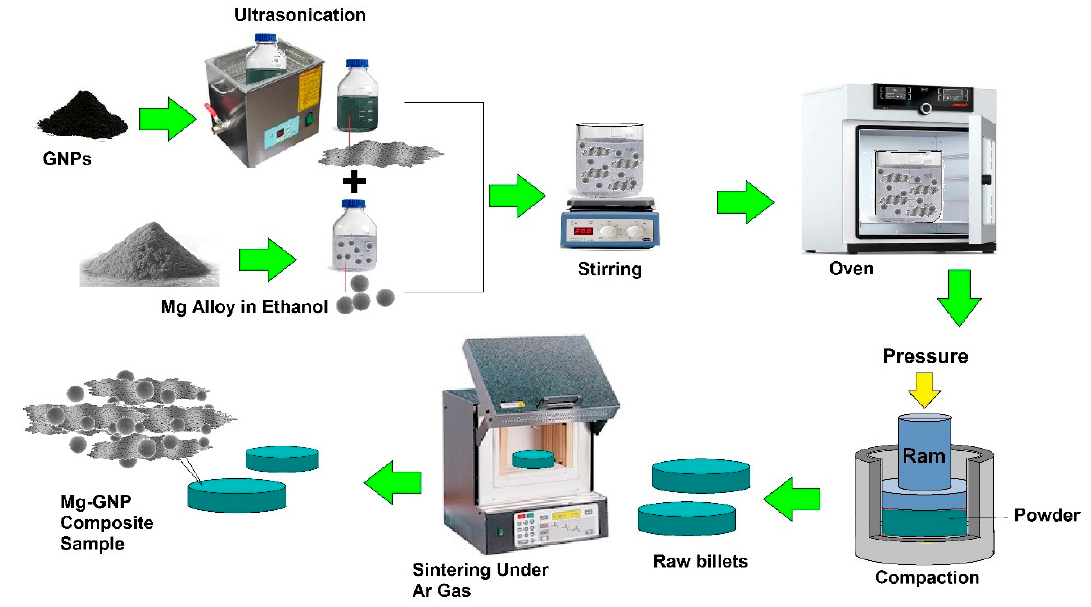
Figure 11. Schematic representation of Semi powder metallurgy (SPM) for synthesis of GNPs reinforced Mg-based composite, reproduced from [110], with permission from Elsevier, 2020.